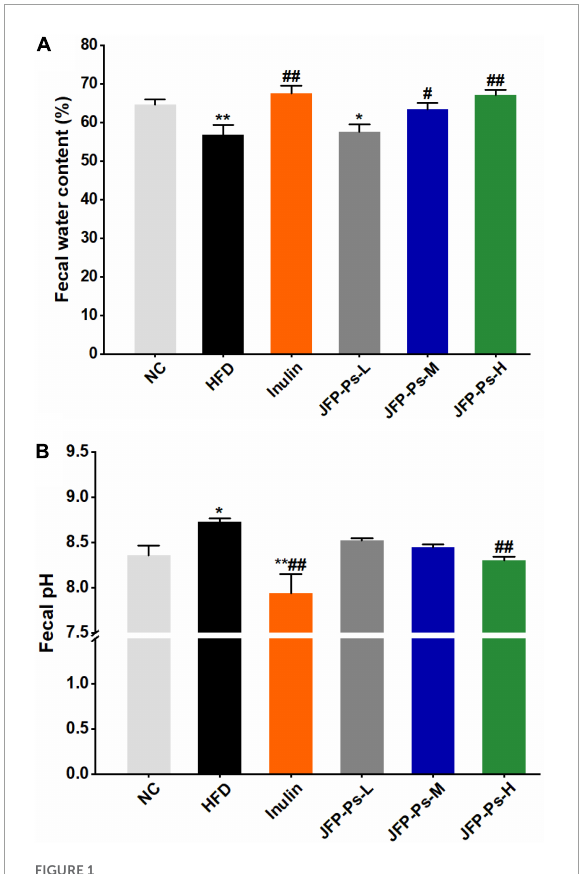
FIGURE1 Effect of JFP-Ps on fecal water content (A) and fecal pH value (B) in obese rats. Data are expressed as mean ± SEM ( n = 6 for each group) and analyzed using one-way ANOVA. * p < 0.05, ** p < 0.01 compared to the NC group; # p < 0.05, ## p < 0.01 compared with the HFD